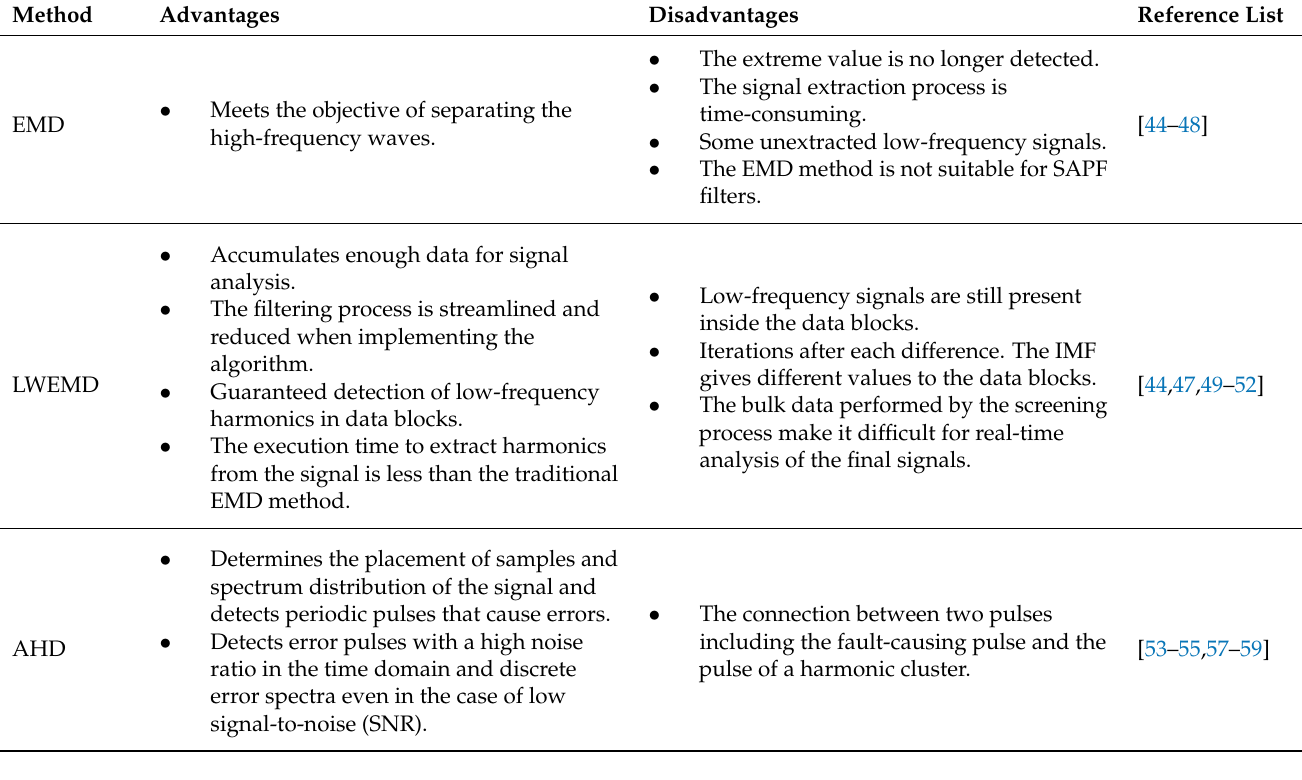
Table 8. Comparison of harmonic signal feature extraction processing